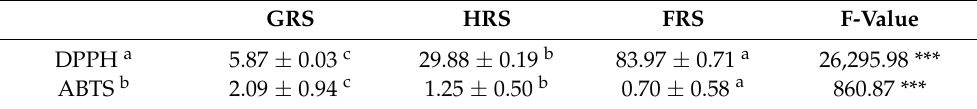
Table 4. Antioxidant properties of Coccinia grandis at different stages of ripening. GRS